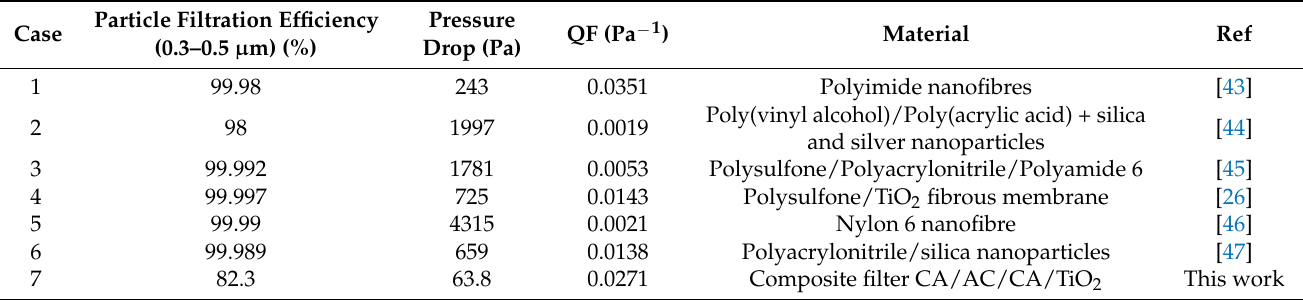
Table 4. Comparison of filtration efficiency for particle size between 0.3 and 0.5 µ m, pressure drop and quality factor at 0.8 m s − 1 with studies in the